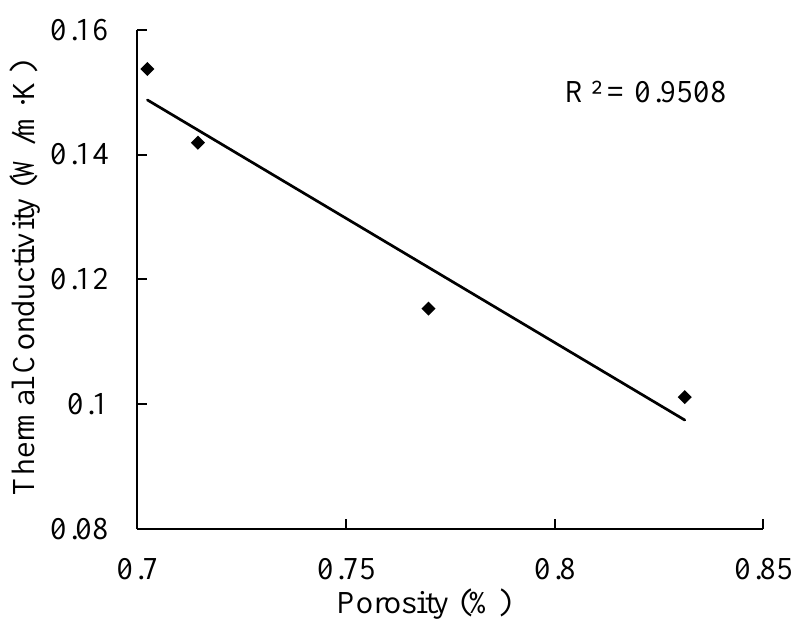
Figure 10. Relationship between thermal conductivity and porosity. The relationship between the pore size and thermal conductivity is shown in Figure 11. The thermal conductivity of AAC increases gradually with the increase of pore size; when the pore size is 0.45 mm, the thermal conductivity increases by about 23% compared with that of 0.35 mm. This is because at the same porosity, the smaller the pore size, the more the number of pores, the path of heat transfer is increased, and the heat transfer efficiency is reduced [36]. The relation can be expressed as Equation (7). K e = 0.0198 + 0.2199 d where d is the pore diameter.